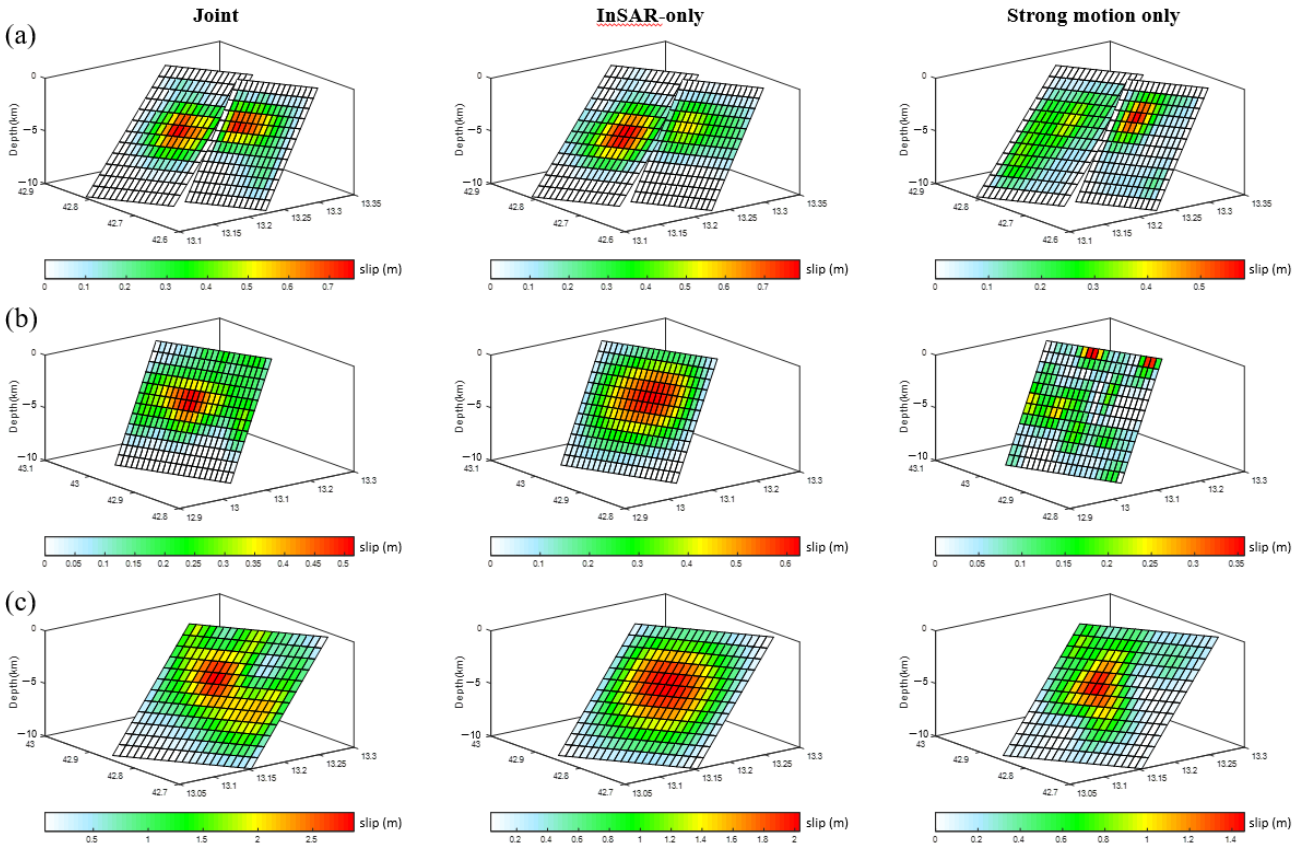
Figure A3. Comparison of slip models using different data constraints. ( a ) The Amatrice earthquake. ( b ) The Visso earthquake. ( c ) The Norcia earthquake.